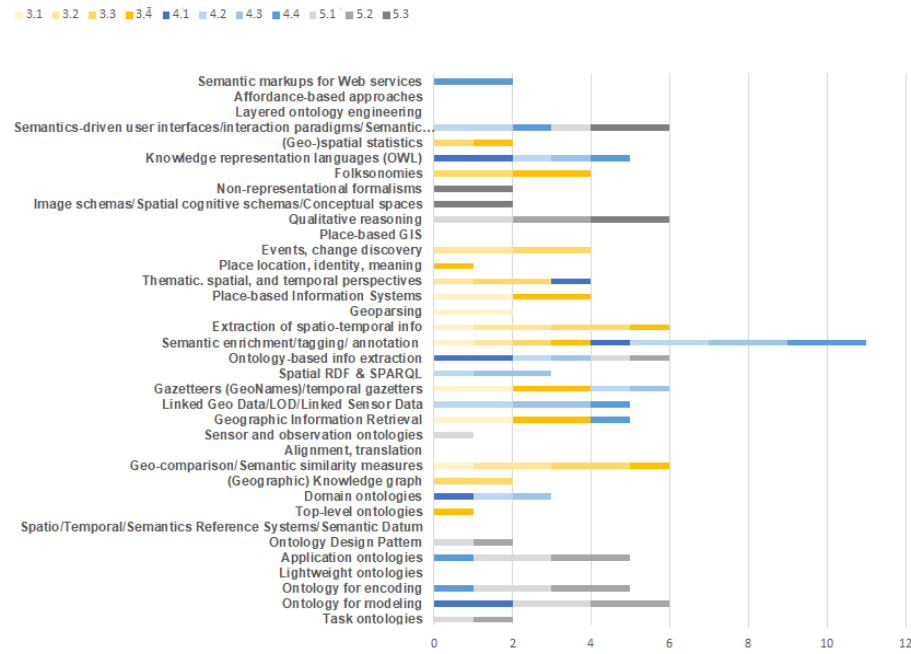
Figure 3. Case studies and the keywords representing their main activities and technologies.